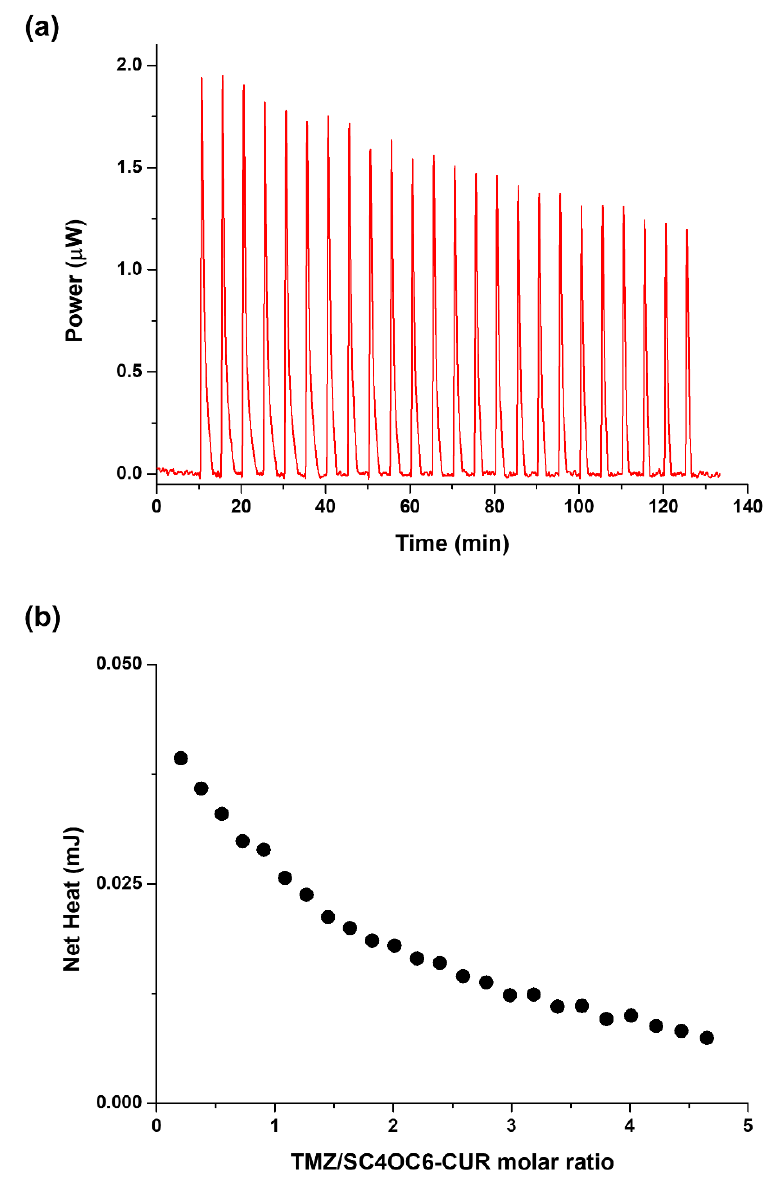
Figure 8. ( a ) ITC titration of TMZ 5 mM into SC4OC6/CUR nanoassembly 0.3 mM (above CMC) at 25 °C in neutral solution (phosphate buffer); ( b ) integrated heat data.